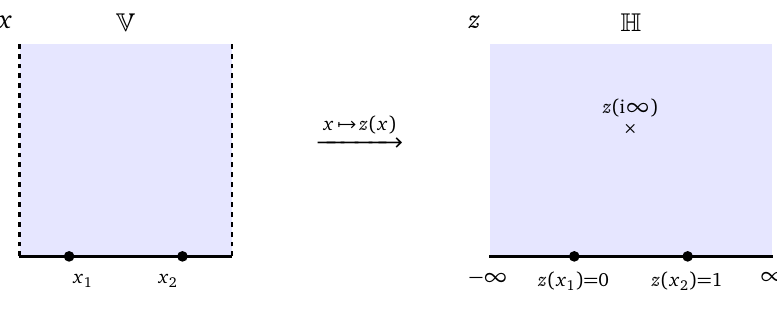
Figure 3: The map z ( x ) from the semi-infinite cylinder V to the upper half-plane H